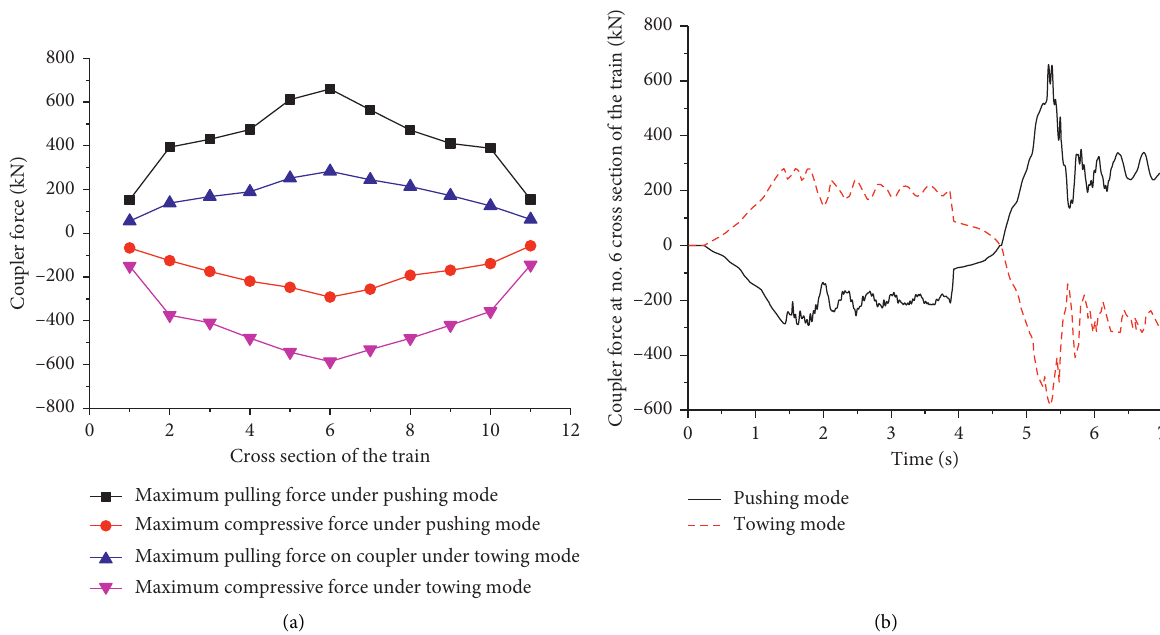
Figure 4: Coupler force when AW0 rescues AW0. (a) Maximum coupler forces. (b) Time history of coupler